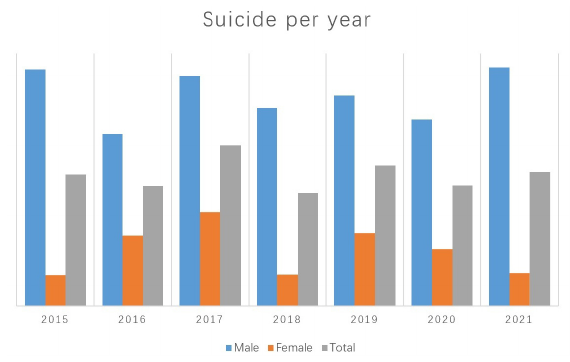
Fig. 1. Suicide per year (cases per 100,000 population).